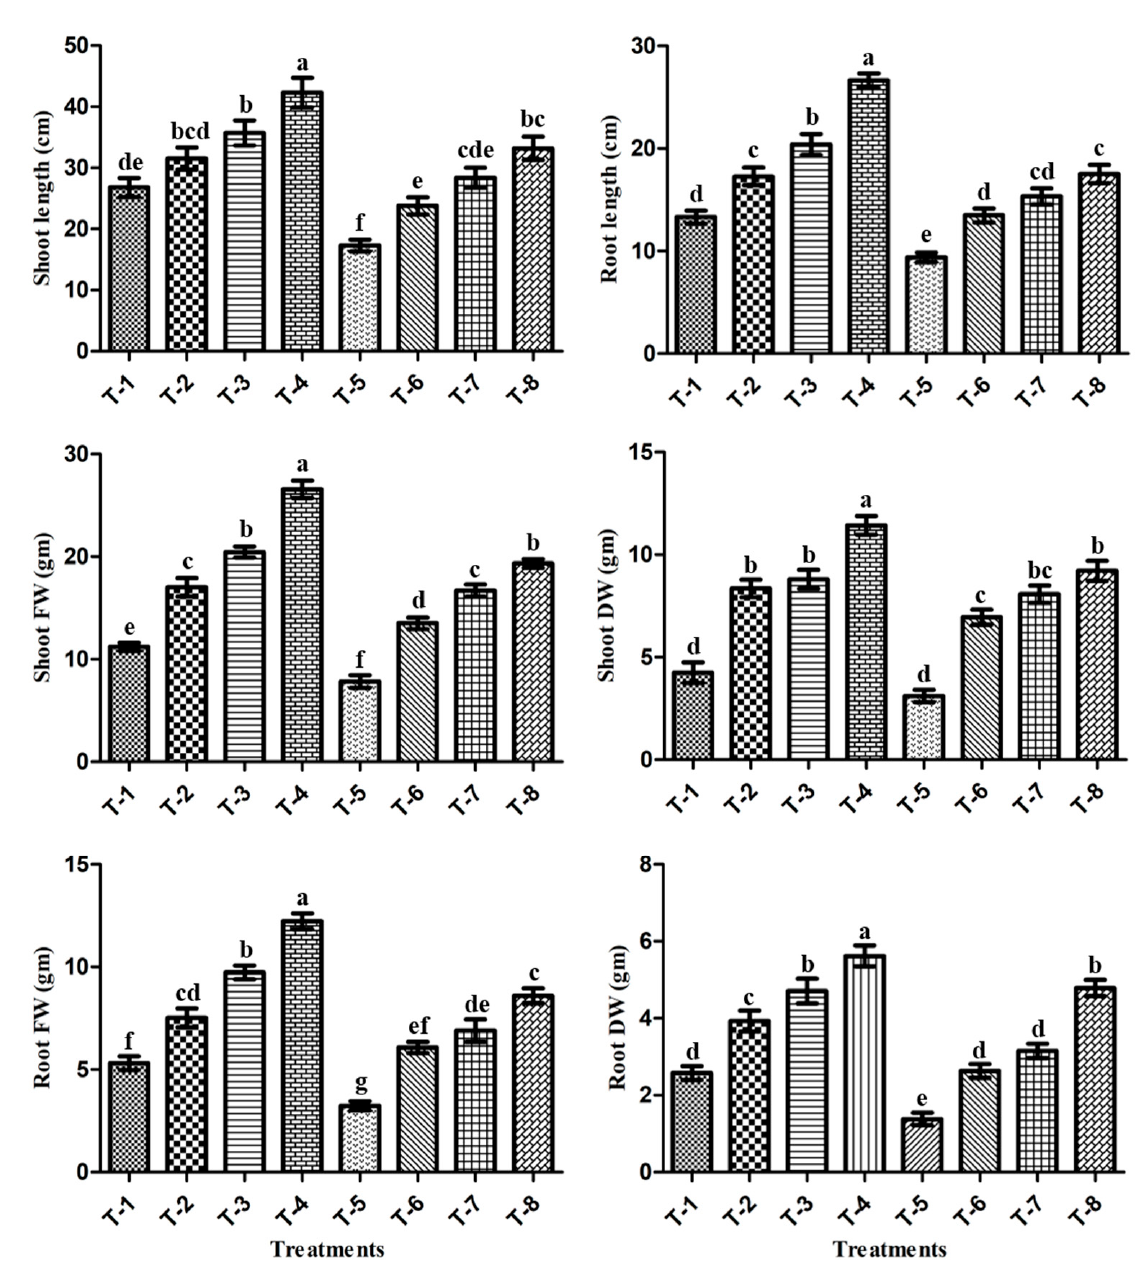
Figure 5. Effect of salt-tolerant PGPR ASN-1 and SNP on sugarcane growth parameters. T-1: Un-inoculated control; T-2: SNP; T-3: PGPR ASN-1; T-4: PGPR ASN-1 + SNP; T-5: NaCl (200 mM); T-6: NaCl + SNP; T-7: NaCl + PGPR ASN-1; T-8: NaCl + PGPR ASN-1 + SNP; FW: fresh weight; DW: dry weight. The mean ± SE, n = 3 is represented. The alphabet letters present on each data bar representing noteworthy variances ( p < 0.05) after the DMRT test.